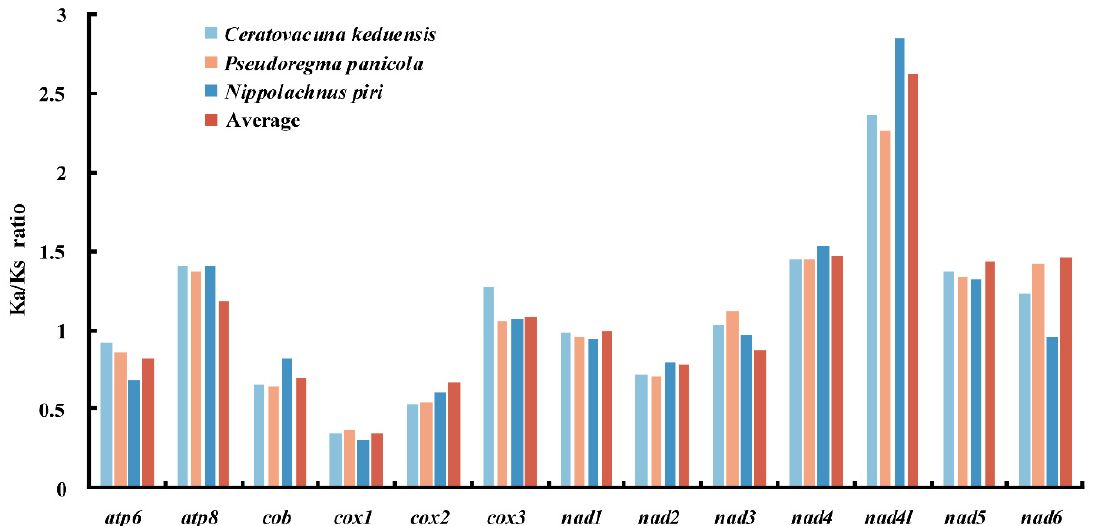
Figure 2. Non-synonymous/synonymous mutation (Ka/Ks) ratios of PCGs in Ceratovacuna keduensis , Pseudoregma panicola and Nippolachnus piri and the average Ka/Ks ratios of PCGs in all known aphid mitogenomes.